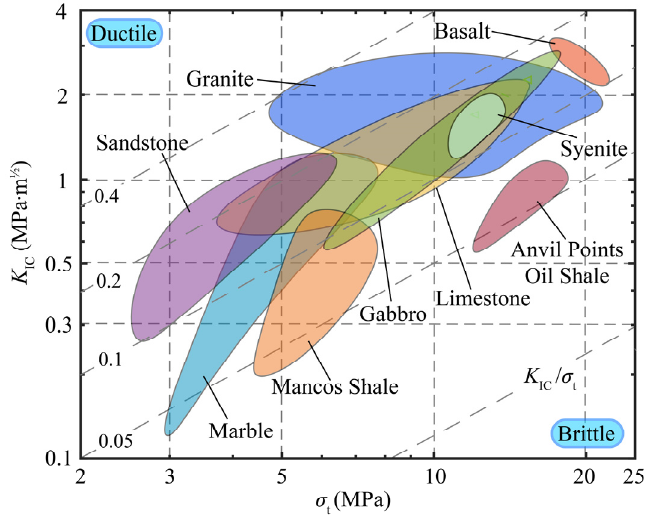
Figure 4. Brittleness of reservoir rocks.